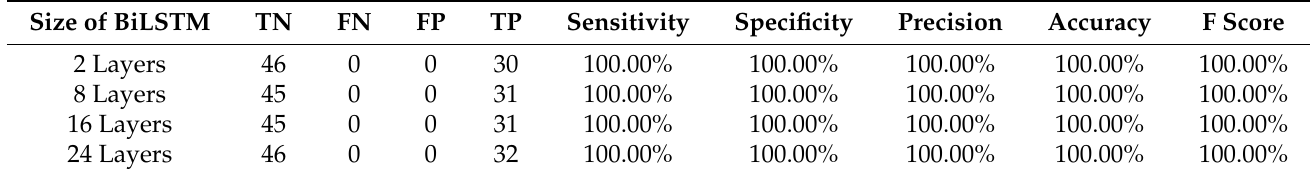
Table 3. Testing results